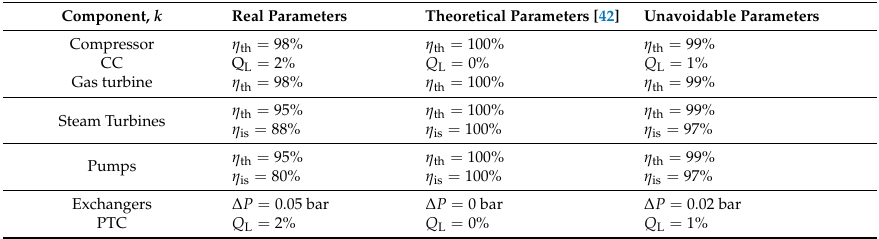
Table 1. Parameters for advanced thermodynamic